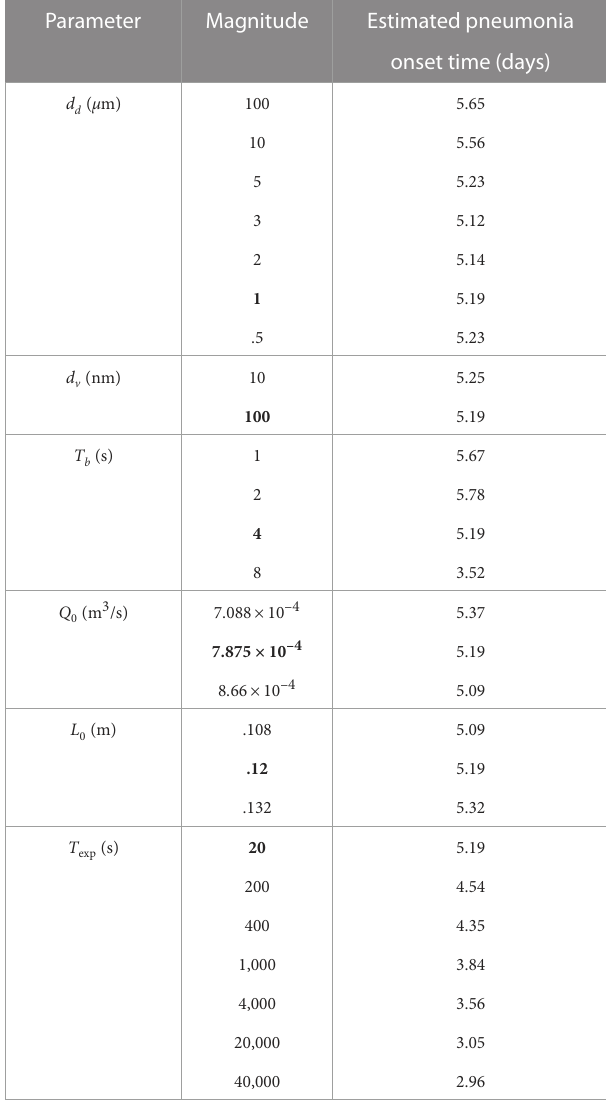
TABLE2 VariationinestimatedtimerequiredforonsetofSARS-CoV-2 pneumoniawithchangeinvariousdimensionalfluiddynamicand